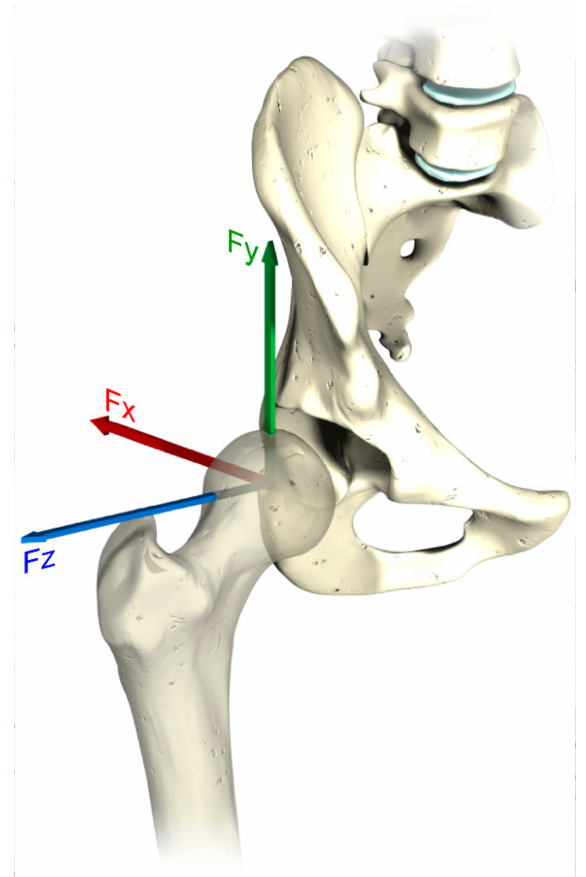
Figure 3. The three force vectors represented on a femoral